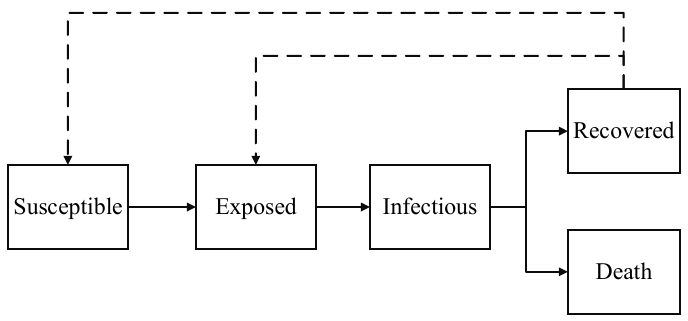
Figure 2. Extended SEIR model.